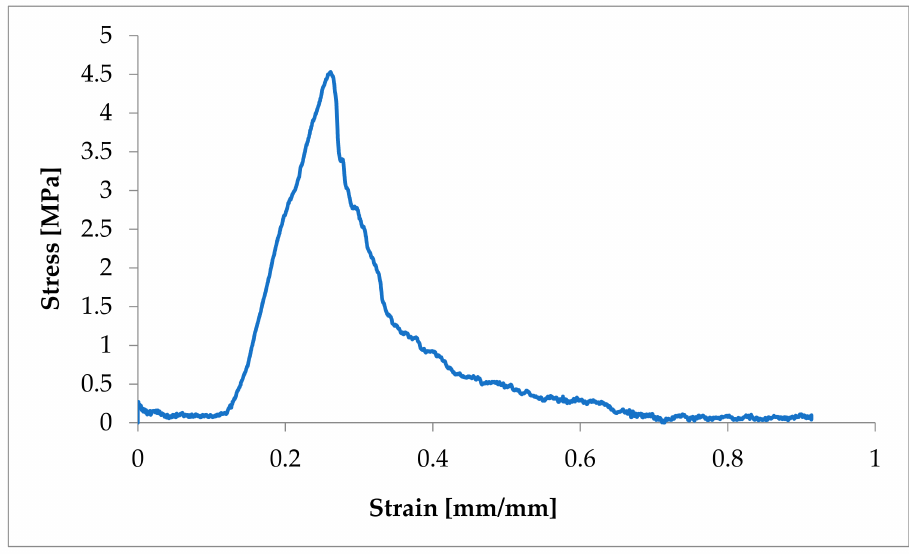
Figure 2. Example of a strain–stress ratio curve in one CT from a dog suffering from